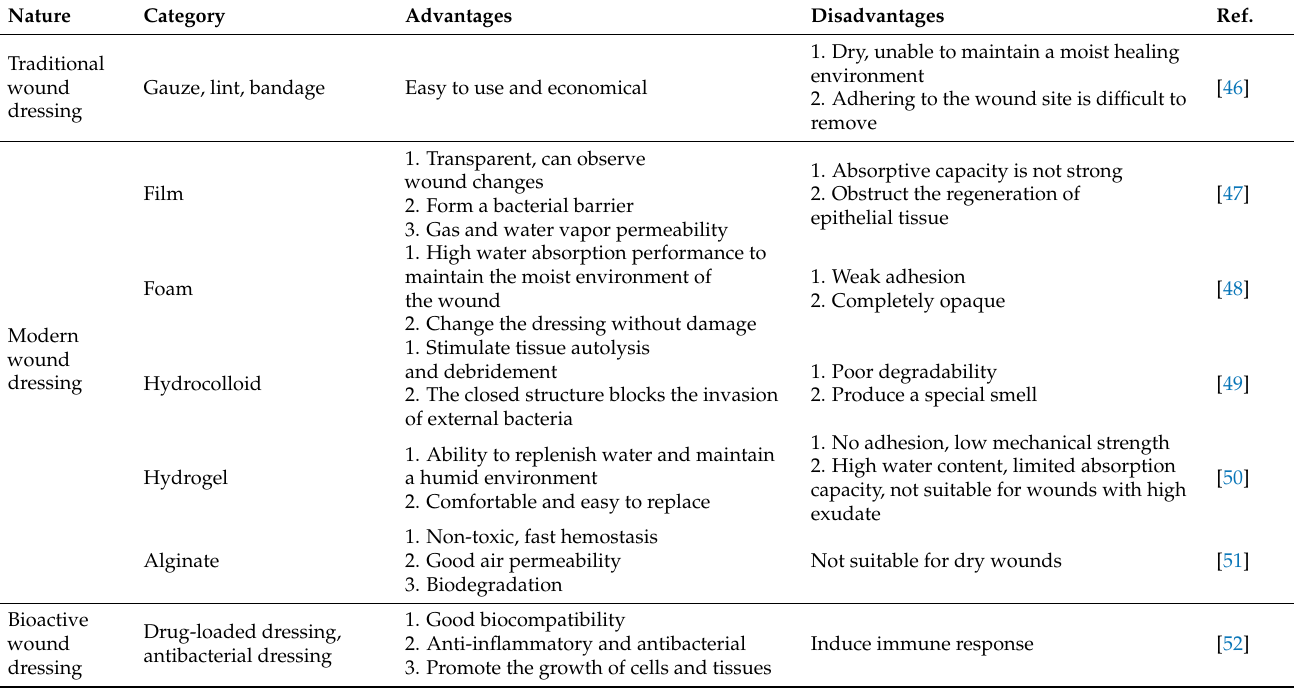
Table 1. Types of wound